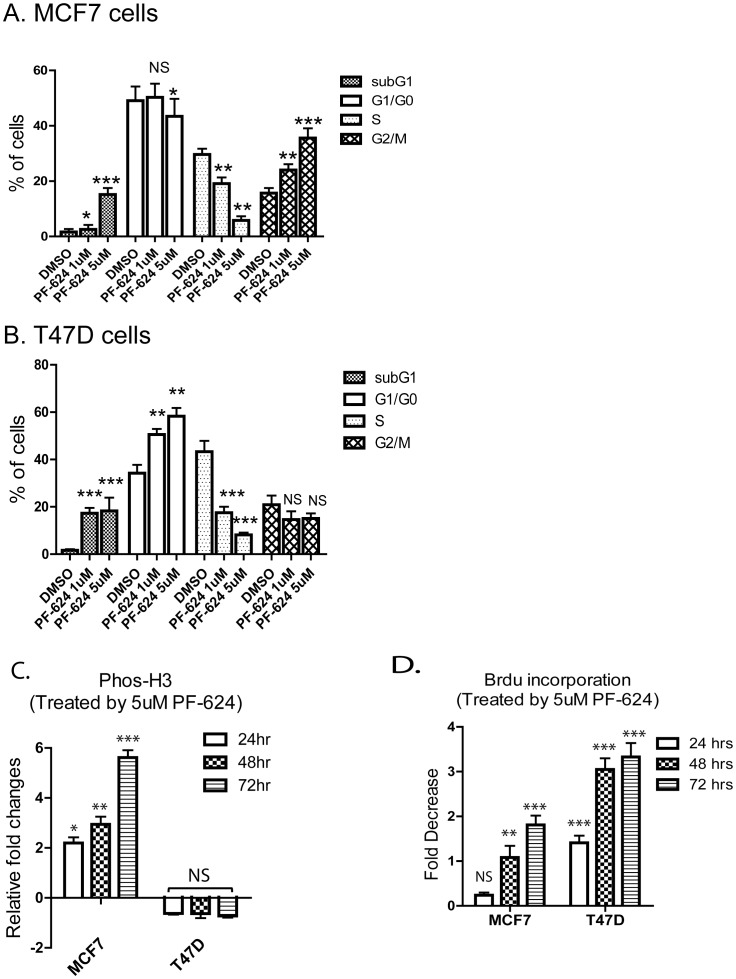
PF-5177624 blocked IGF-I induced cell cycle progression in MCF7 and T47D cells.Cells were serum-starved for 24 hours in order to synchronize cells at the G0/G1 stage. Cells were pre-treated with DMSO or PF-5177624 for 2 hours prior to addition of IGF-I for 6, 18, 24, 48, or 72 hours. Cells were subsequently harvested, fixed, and stained with PI and cell cycle profiles were obtained by flow cytometry. Bar graphs indicating the percentages of cells in the various cell cycle stages at the 72 hour time point are shown in (A) and (B). Phosphorylation of Histone H3 was determined on cells treated with 5 µM PF5177624 for 24, 48, and 72 hours and normalized to DMSO treatment at the same time points as shown in (C). MCF7 and T47D cells were also incubated with BrdU and subject to FACS to measure incorporation of new DNA. The fold decrease of BrdU incoporation relative to DMSO treatment at the same time point are shown in (D). The t-test was performed to determine if there were differences in samples treated with compound versus DMSO at the same time point; *  =  p<0.05, **  =  p<0.001, ***  =  p<0.005.